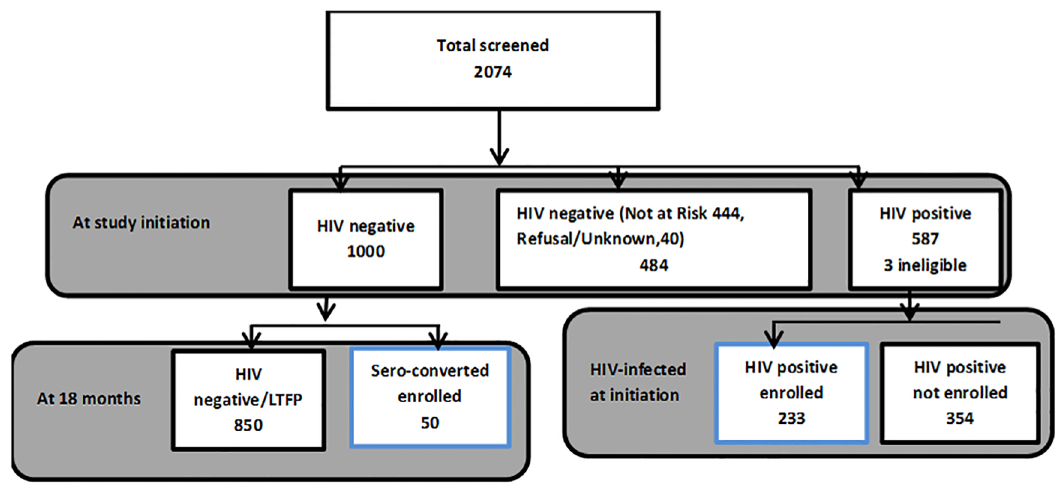
Fig 2. Enrolment of study